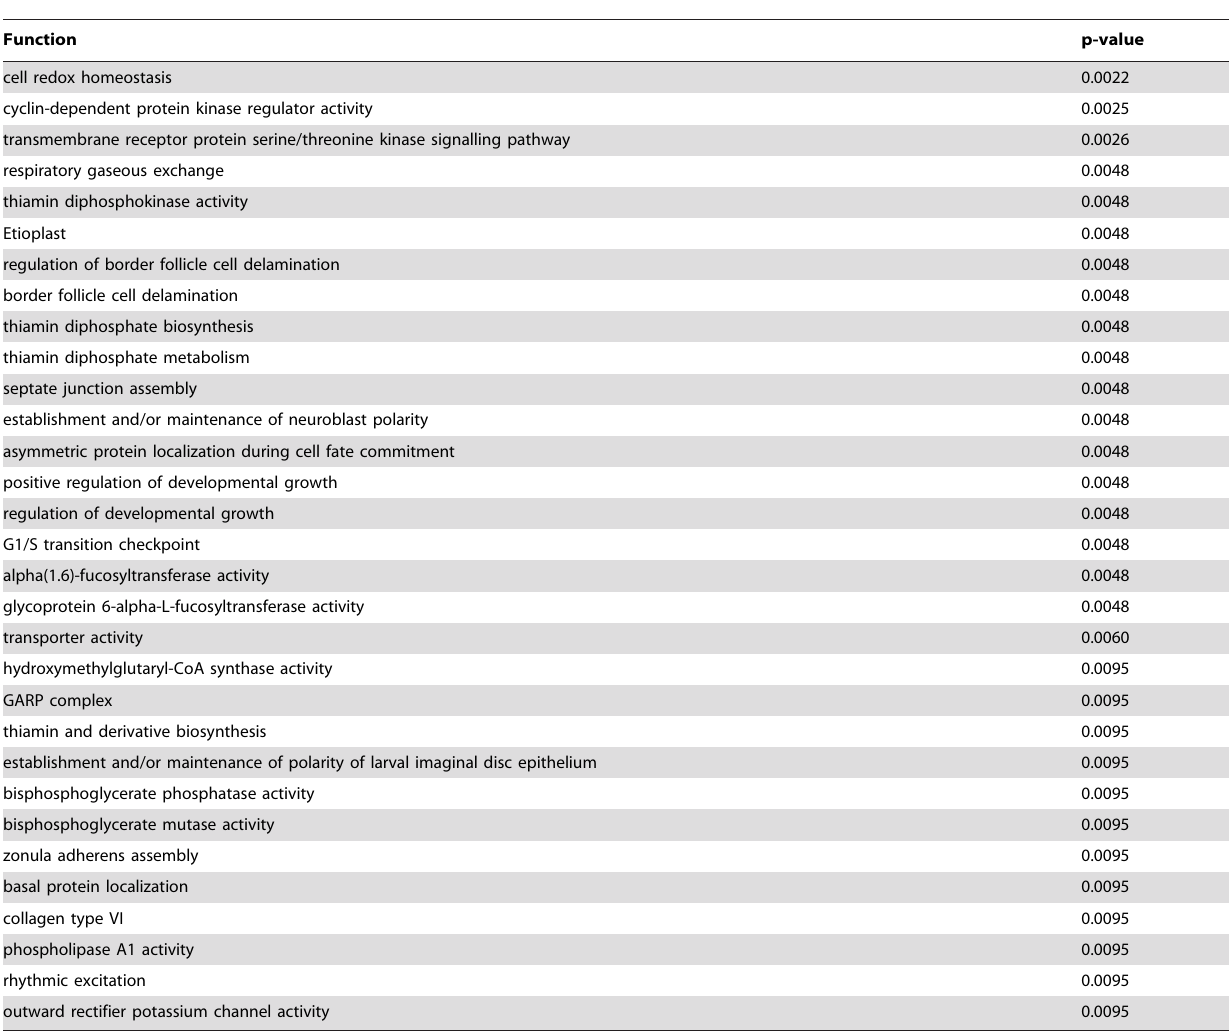
Table 6. Downregulated functions in CC B + compared to CC B-